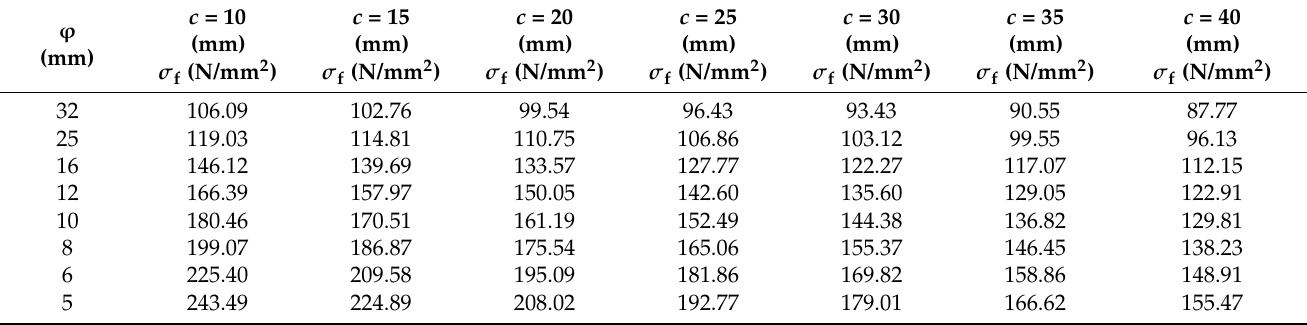
Table 4. Stresses in FRP bars for maximum allowable bar diameter and different concrete